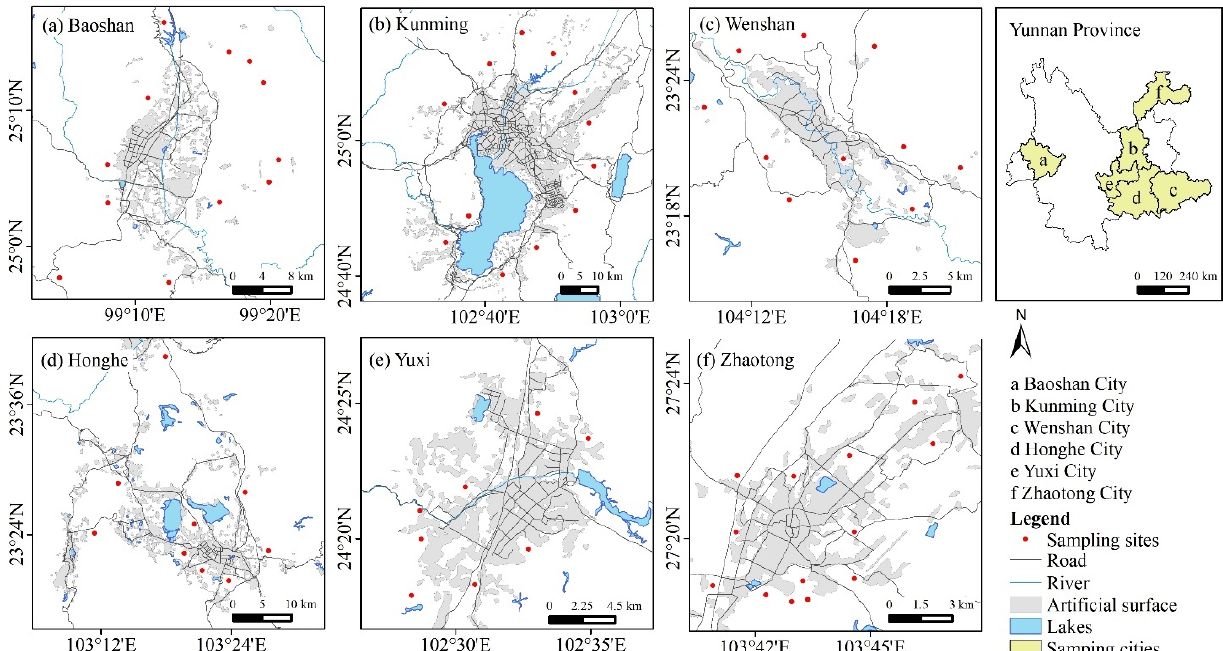
Figure 1. Locations and spatial distributions of the sampling sites for soil dust around the urban areas in six cities.